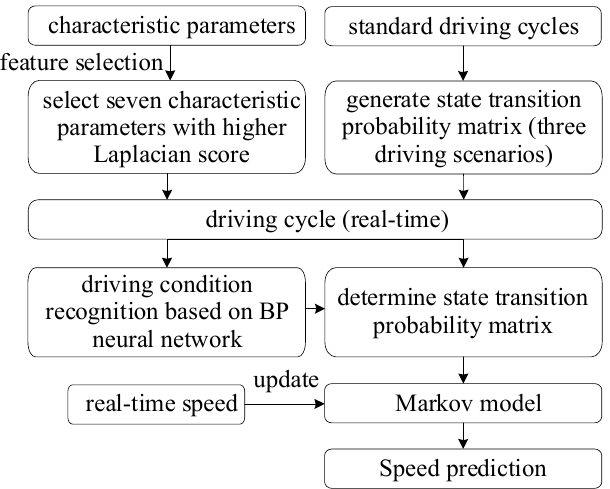
Figure 5. Overall process of speed prediction.